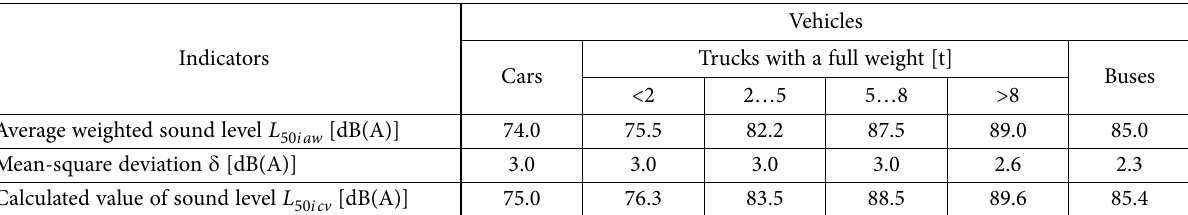
Table 2. Estimated values of the sound level of a vehicle